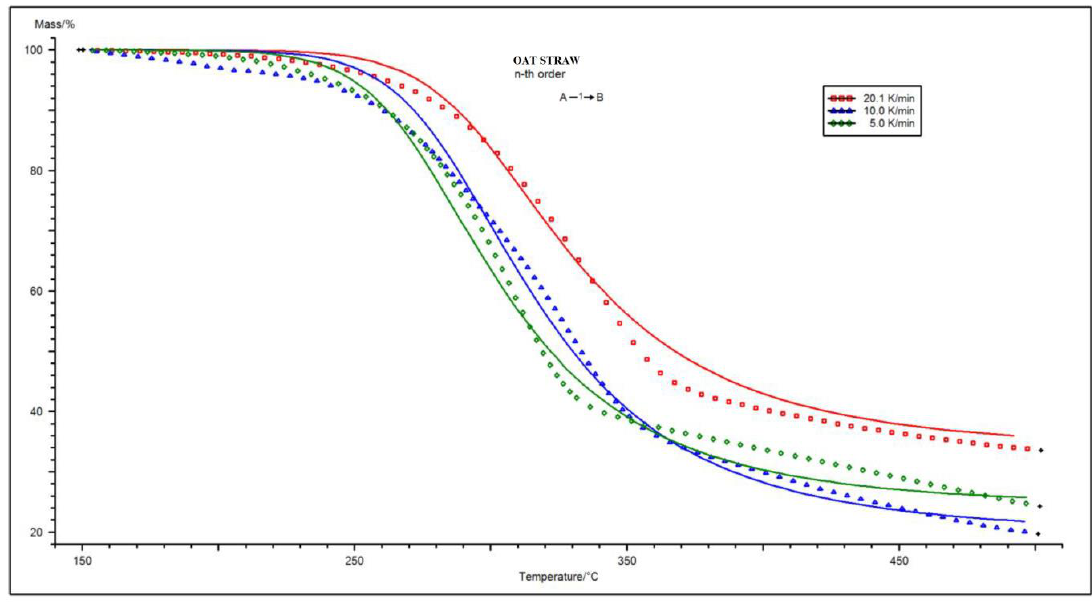
Figure 9. Fitting the calculated kinetic model to the experimental data for the oat straw sample.